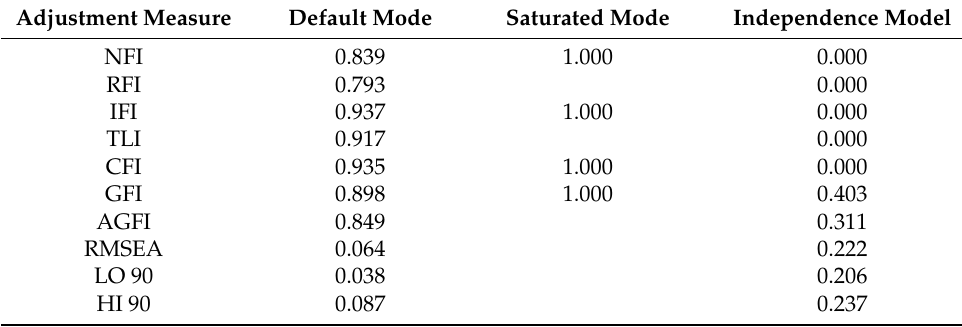
Table 7. Confirmatory factor analysis. Model adjustment